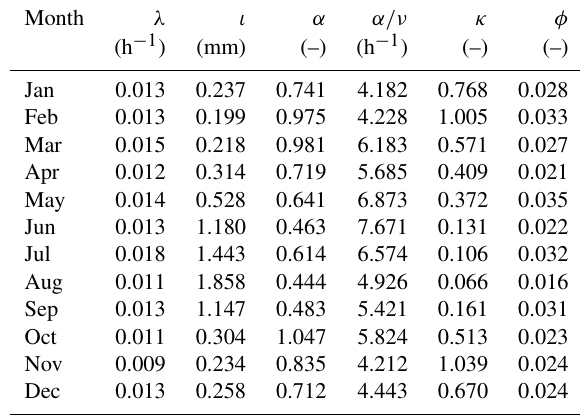
Table 3. Parameters for the RBL1-sM-NC model using Bochum gauge data; constraint: α > 2.